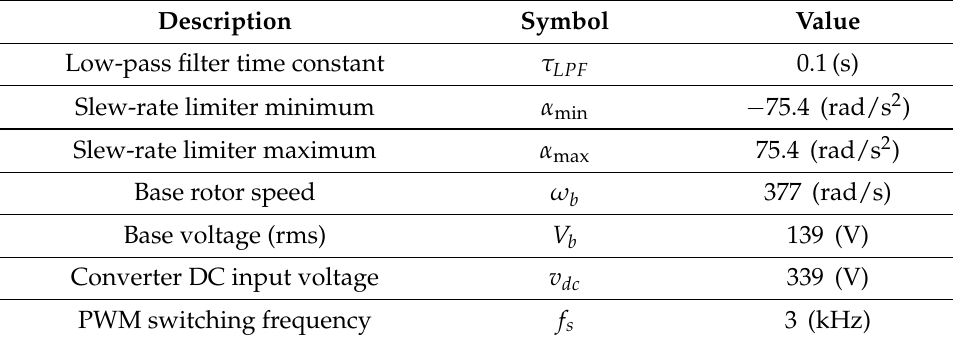
Table A3. Parameters for Compensated Volts-per-Hertz